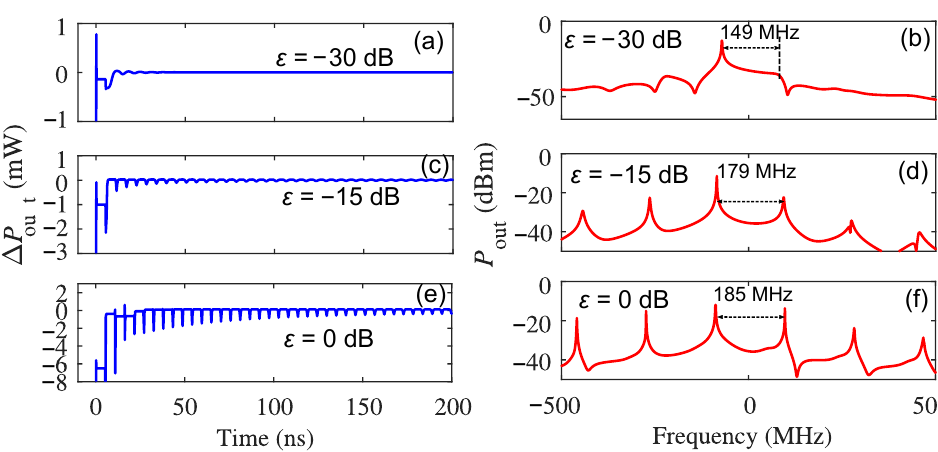
Figure 4. The cumulative effects of the first, second, and third ECRTs on the self-pulsation dynamics in a THz QCL under optical feedback: ( a , c , e ) are the AC component of the emission power ∆ P out when ε is − 30 dB, − 15 dB, and 0 dB, respectively; ( b , d , f ) are the emission spectrum (offset to the emission frequency 2.752 THz) when ε is − 30 dB, − 15 dB, and 0 dB,